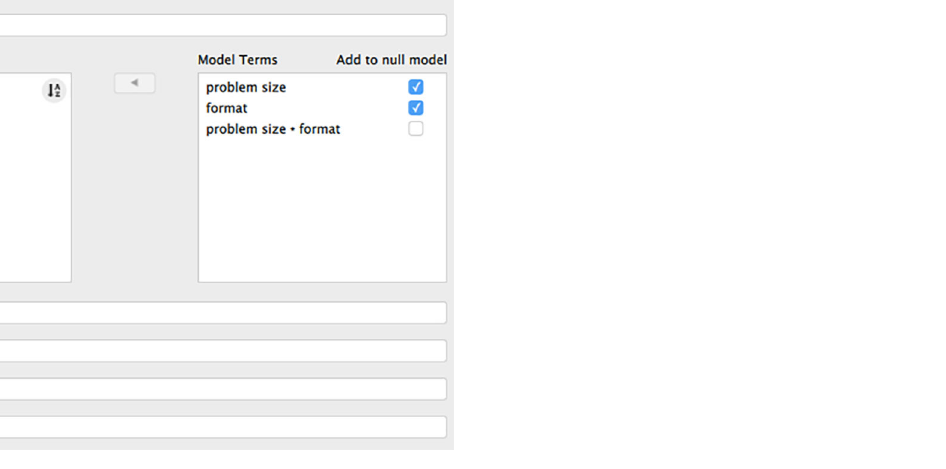
Figure 12. Adding the factors of problem size and format to the null model in a Bayesian Repeated Measures ANOVA.